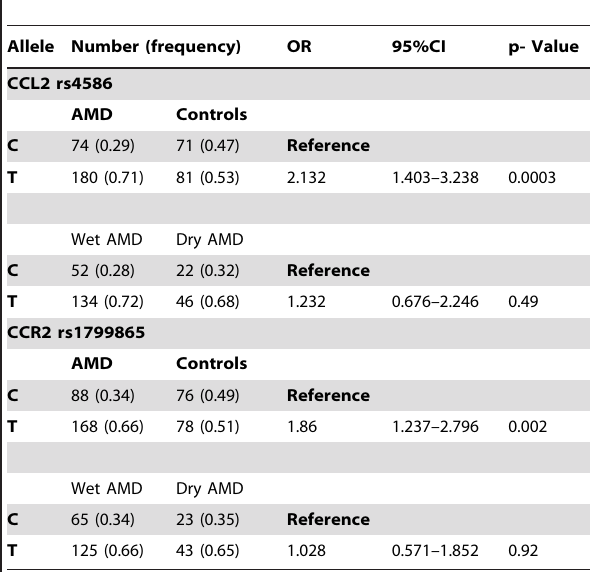
Table 4. Allele frequency of CCL2 and CCR2 in AMD and Normal controls.